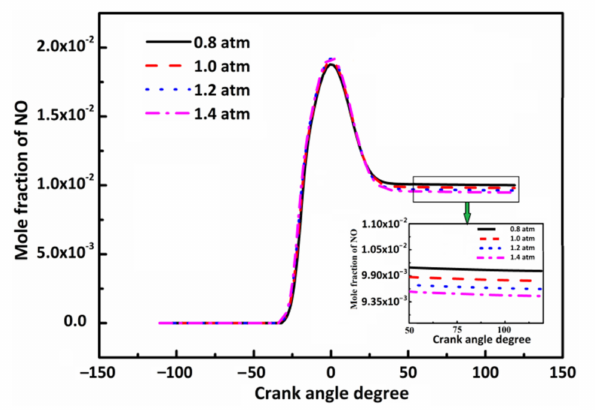
Figure 6. Effect of initial combustion pressures on NO